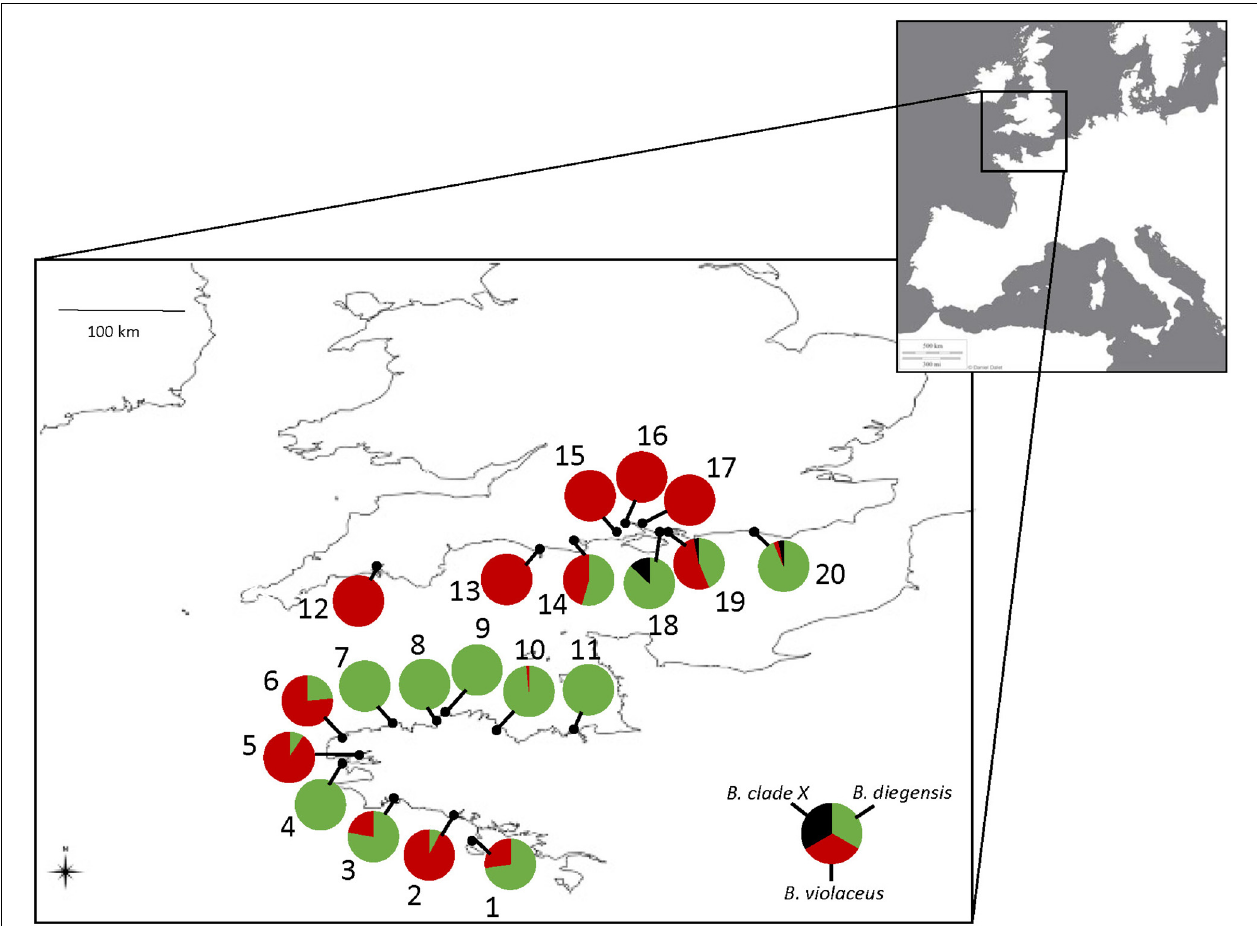
FIGURE 1 | Study area and sampling localities of the 627 single-color colonies sampled in the English Channel and morphologically assigned to B. violaceus , with pie charts indicating the percentage of the three Botrylloides taxa, after being identified with molecular barcoding (see Table 1 ). Numbers refer to population name as indicated in Table 1 . The source for the European map in the inset is ©Terre